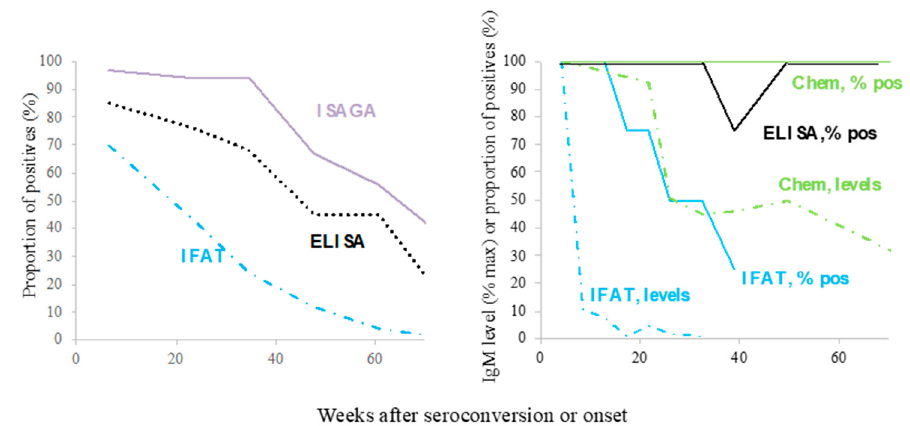
Figure 4. Kinetics of IgM decline assessed by different techniques and data presentation form (proportion of positives versus antibody levels) in two studies that compared these parameters with the same samples [35,37]. In both works, the patients had clinically active acquired infection.